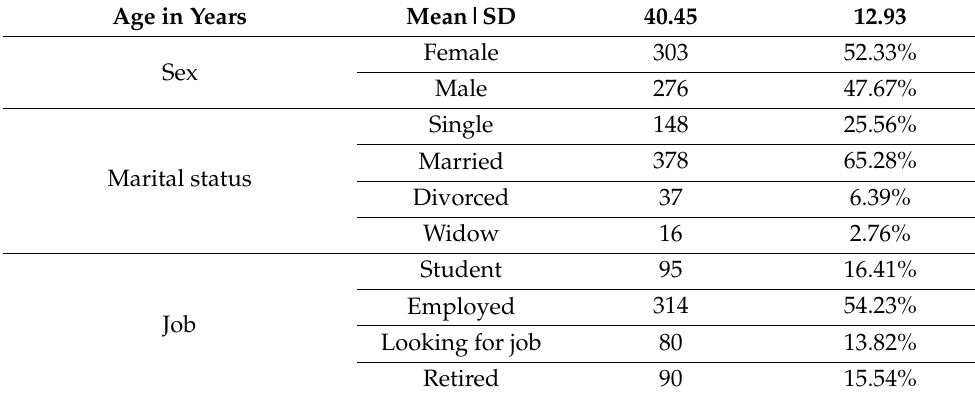
Table 1. General characteristics of the participants (n =